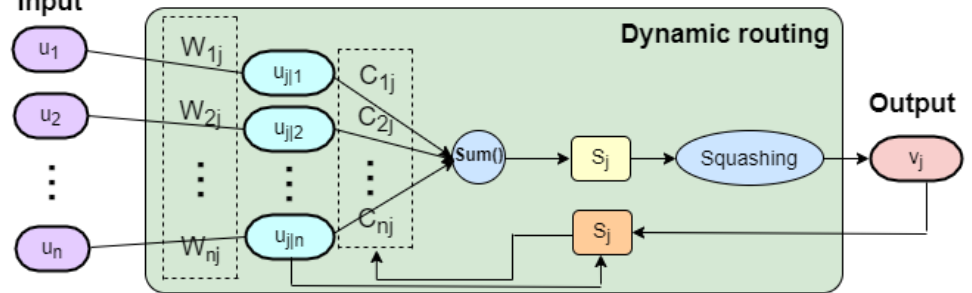
Figure 5. The dynamic routing algorithm in capsule network.